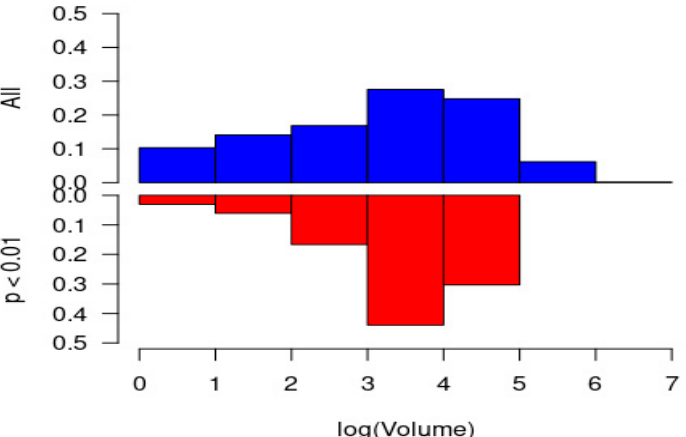
Figure 6. Distribution of cohort patient volume (log scale) for all hospitals (top, blue) versus those with substantial levels of misutilization, identified as p < 0.01 (bottom, red).